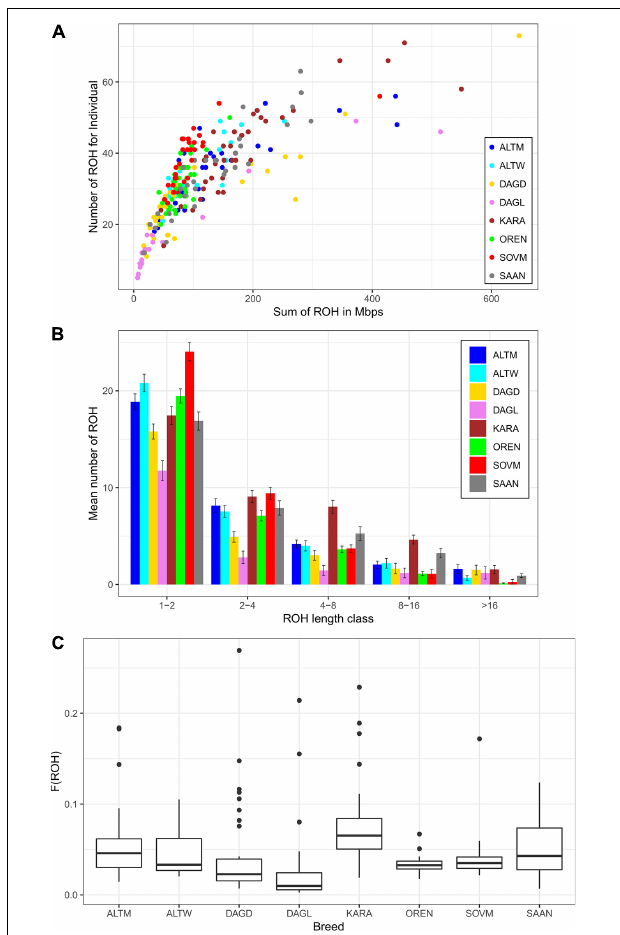
FIGURE 2 | Patterns of runs of homozygosity (ROH) in Russian goat populations: genomic coverage in ROH ( X -axis) and ROH number per individual ( Y -axis) (A) , ROH distribution in length classes (B) , and variations of the runs of homozygosity inbreeding coefficient (F ROH ) within each goat group (C) . For a description of the goat breeds, see Table 1